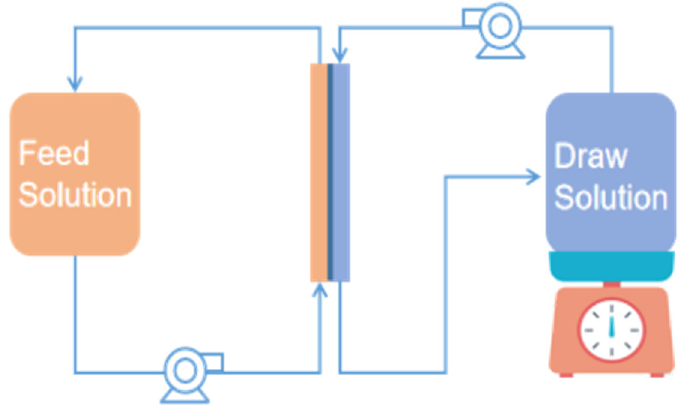
Figure 1. The flow chart of the FO membrane system.